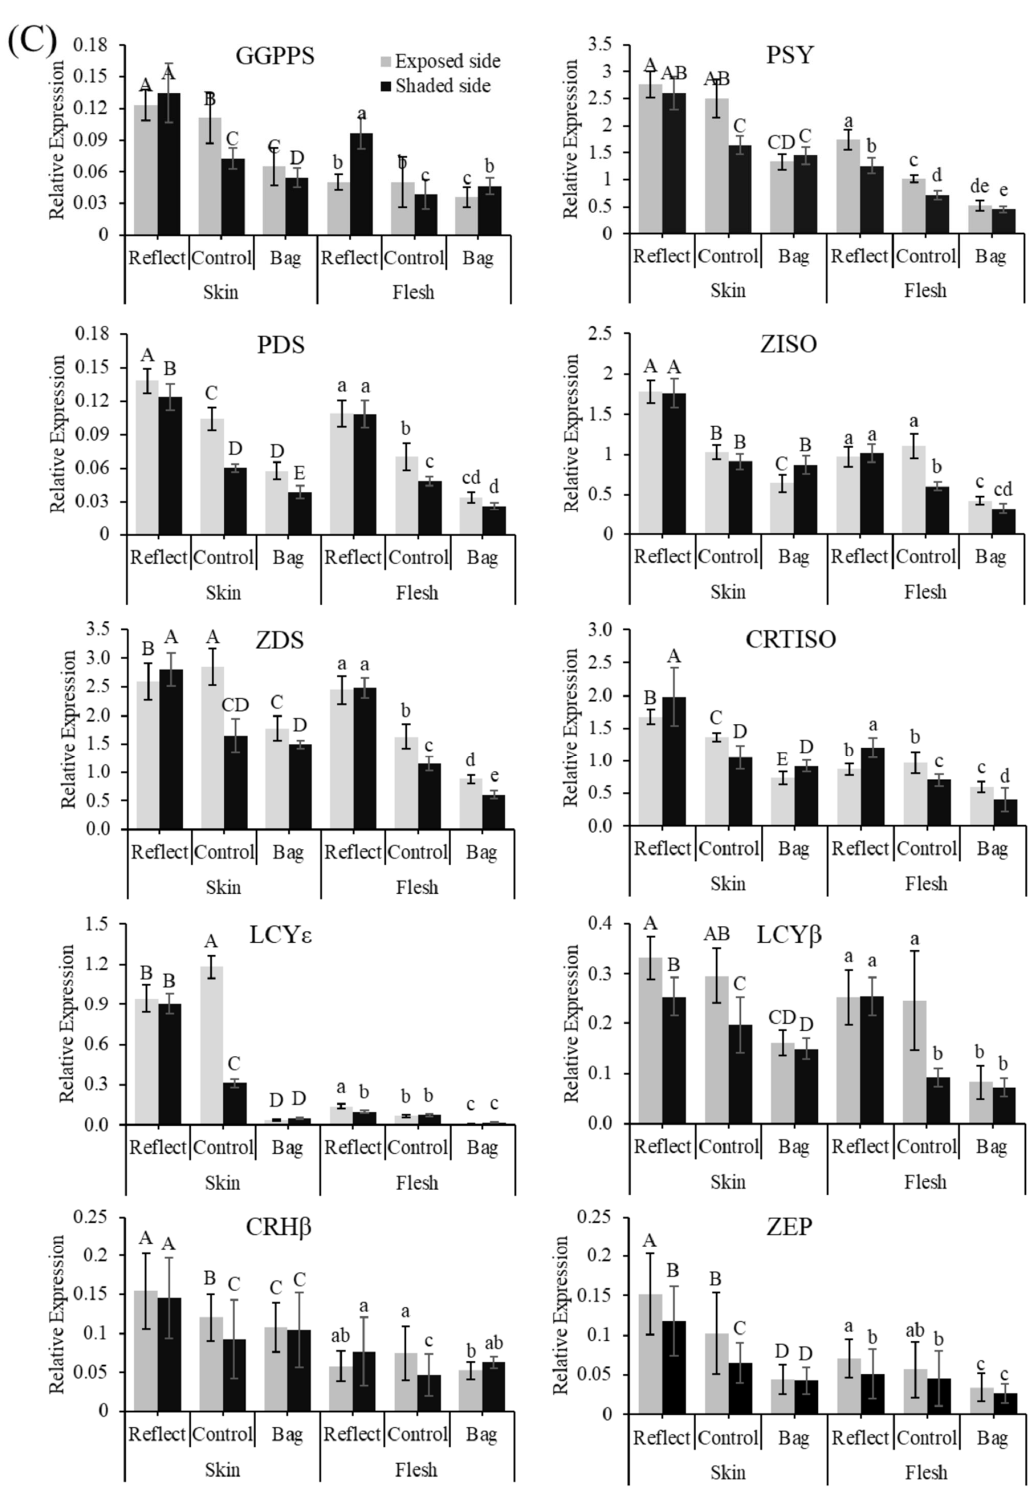
Figure 3. Carotenoid biosynthesis pathway ( A ). Expression profiles of carotenoid biosynthesis- related genes in the peel and flesh of three apple fruit groups: reflected, control, and bagged on the exposed and shaded sides of the apple ‘Arisoo’ ( B ), and ‘Summer Prince’ ( C ) under different treatment conditions. All qRT-PCR reactions were normalized to an apple SGF 29 tudor-like domain- containing protein ( MDP0000336547 ) gene. Different uppercase and lowercase letters represent a significant difference ( p < 0.05) in the peel and flesh, repectively. Data are means ± SD of three biological